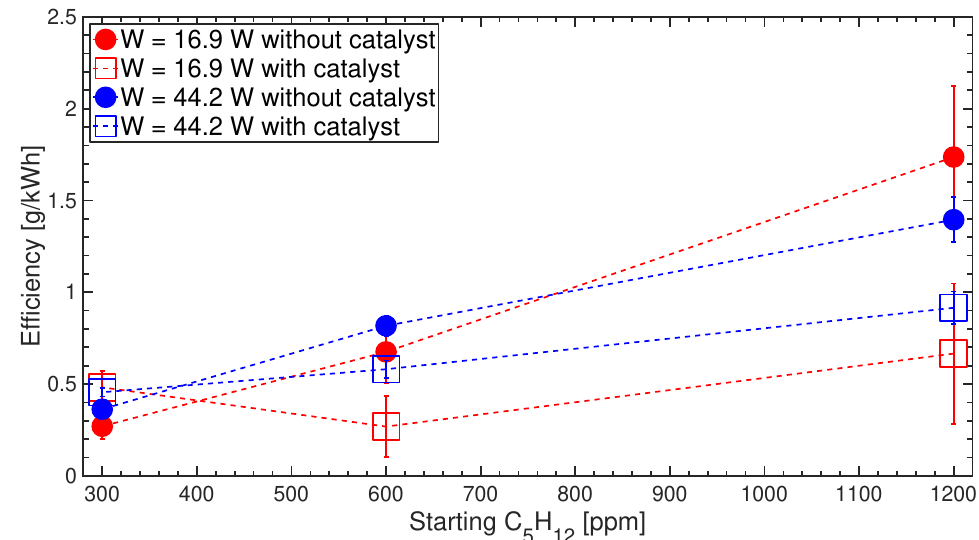
Figure 6. Pentane decomposition efficiency (g/kWh) after 1 min of plasma treatment according to the initial pentane concentration. The lines serve as visual guides. The error bars were obtained by calculating the error propagation in the estimation of the